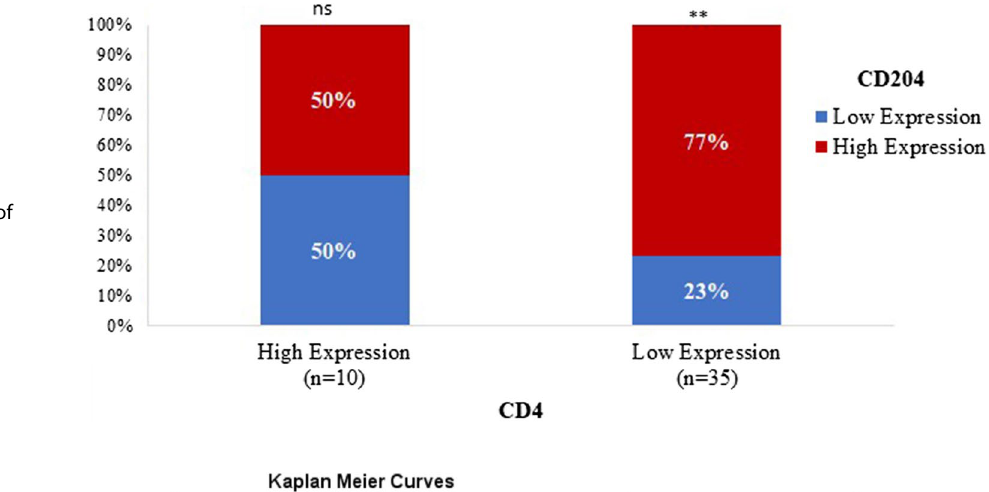
Fig. 3 A diagram illustrat- ing the inverse correlation between CD204 + TAMs and CD4 + TILs. Approximately